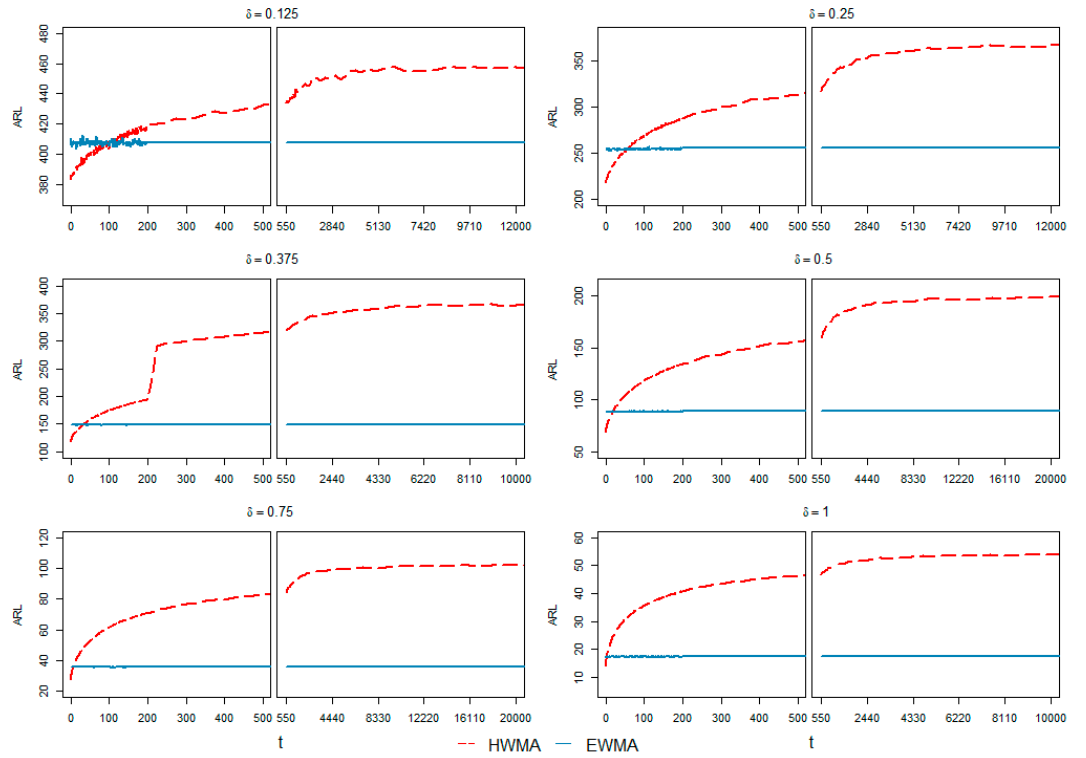
Figure 10. CED curves for the HWMA and EWMA charts under small to moderate shifts at λ = 0.5 with respect to time points ( t ) .